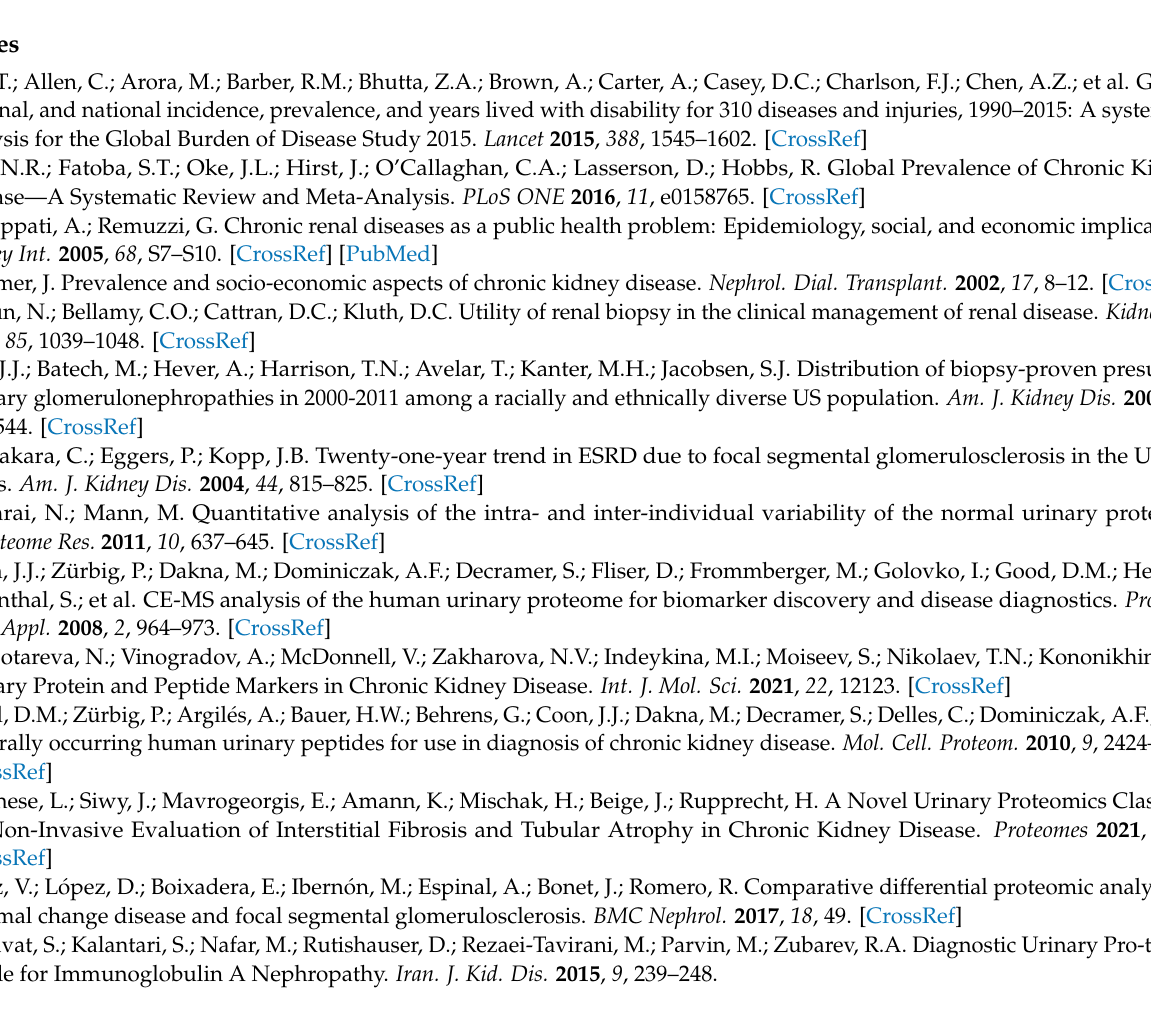
Table S8: Parameters of the algorithms for